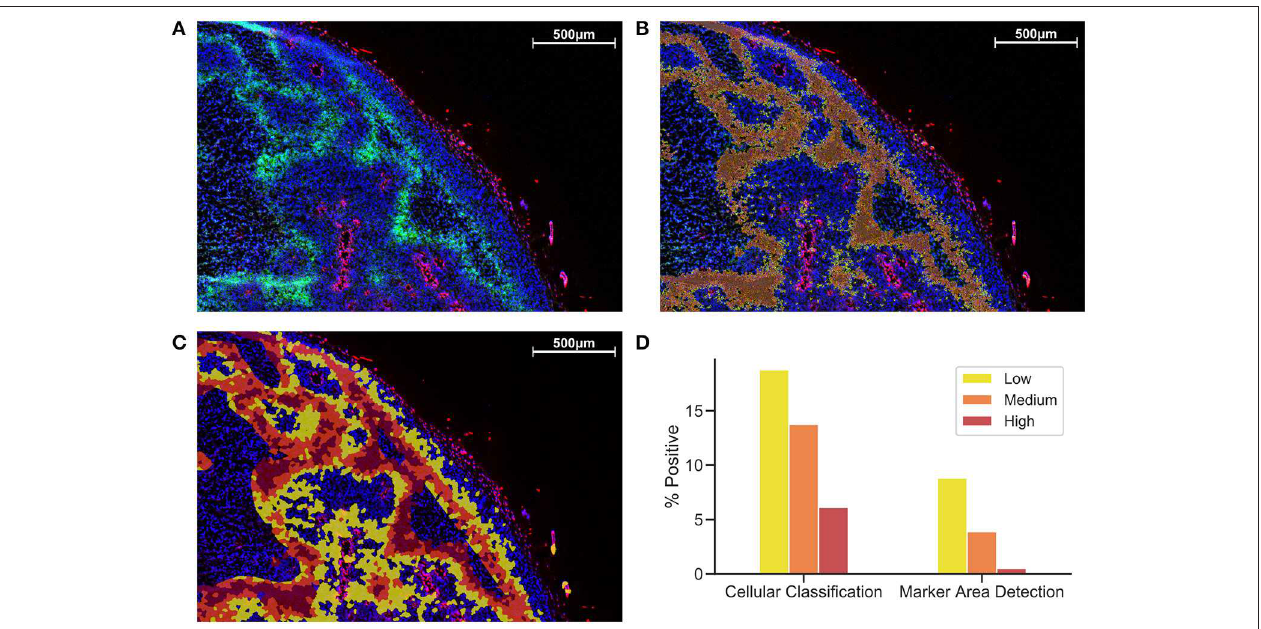
FIGURE 1 | Comparison of Cellular Classification and Marker Area Detection. (A) Immunofluorescent staining with DAPI in blue, Hoechst in red, and EF5 in green. (B) MAD with low (yellow), medium (orange), and high (red) hypoxic areas. (C) CC with the same overlay classification as previously used for MAD. (D) Comparison of percent positive scores for each EF5 intensity grouping in CC compared to